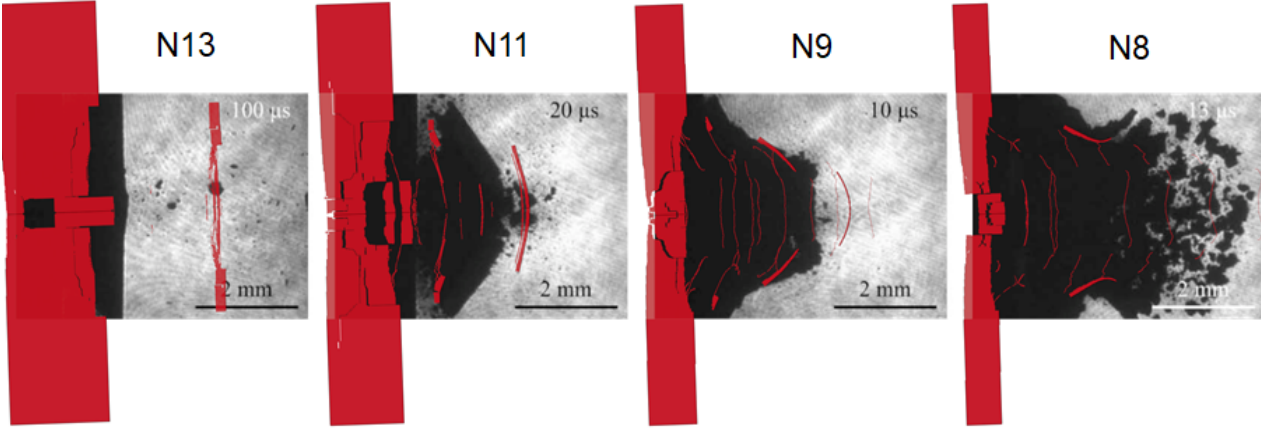
Figure 12. Numerical simulations of shots N13, N11, N9 and N8 and the respective shadowgraphies (reprinted from [28]).